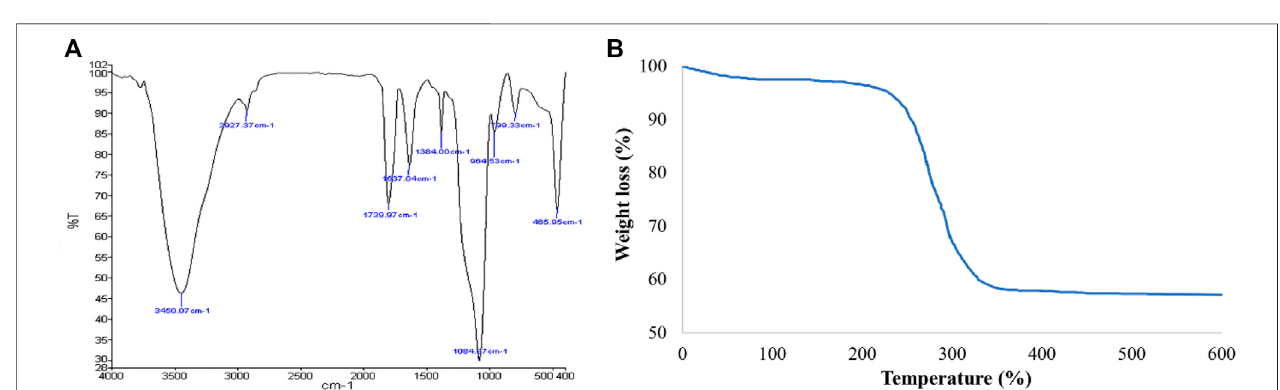
FIGURE 2 | (A) FT-IR; and (B) TGA results of the Pd@Py 2 PZ@MSN catalyst.